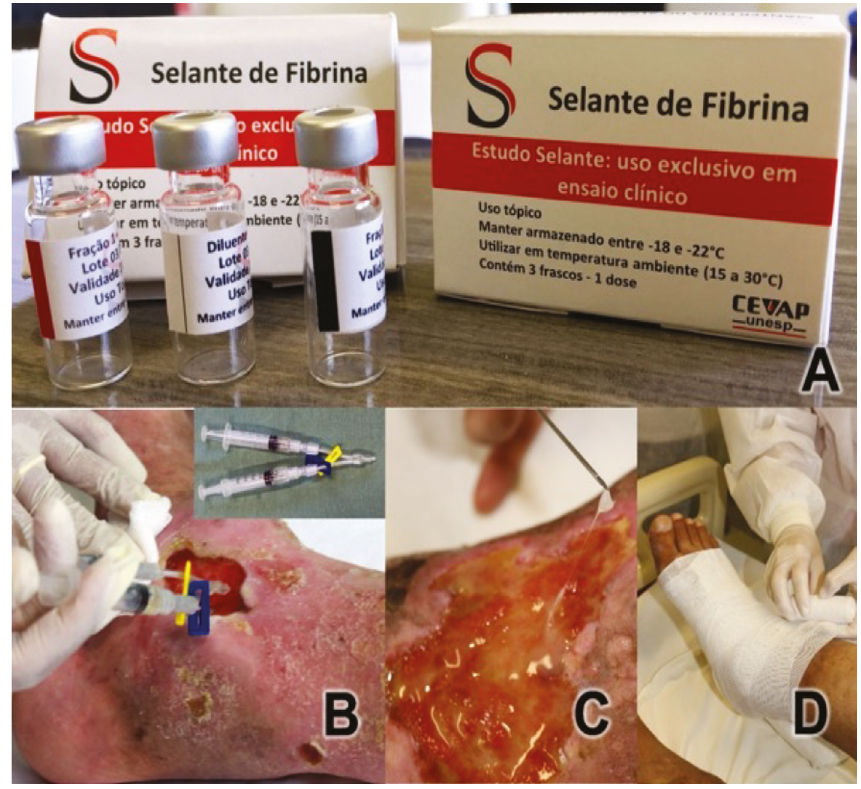
Figure 1. Application of the Heterologous Fibrin Sealant in chronic venous ulcer. Reprinted from “Treatment of chronic venous ulcers with Heterologous Fibrin Sealant: a phase I/II clinical trial” by Abbade et al. [12].